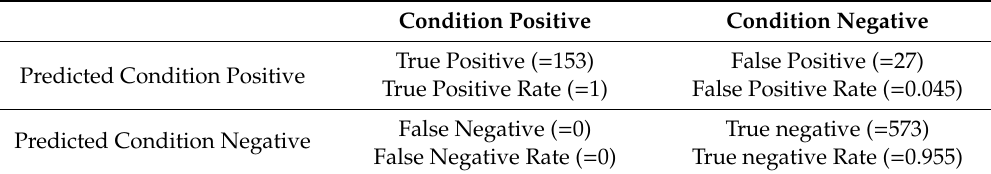
Table 3. Confusion matrix of quench detection.